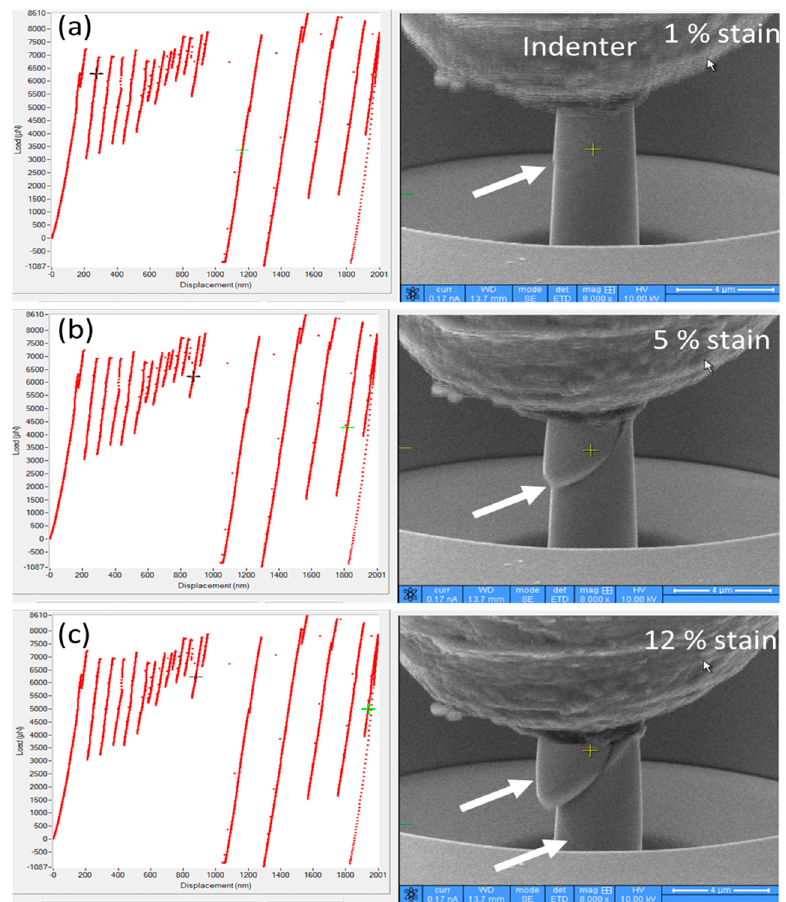
Figure 5. Representation of the physical appearance of a micro-pillar at different strain intervals (as marked with arrows) during compression: ( a ) at 1% strain, ( b ) at 5% strain, and ( c ) at 12% strain. The white arrows indicate the location of slip/shear band formation.